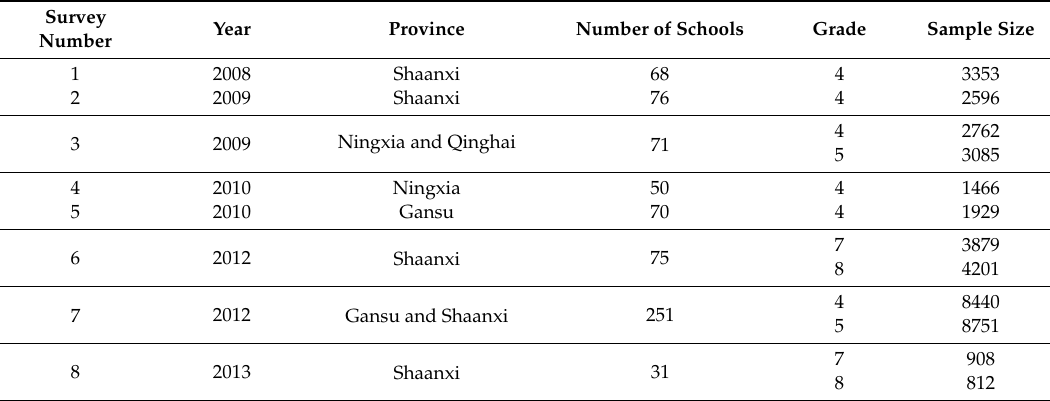
Table 1. Description of surveys and datasets of the sample.